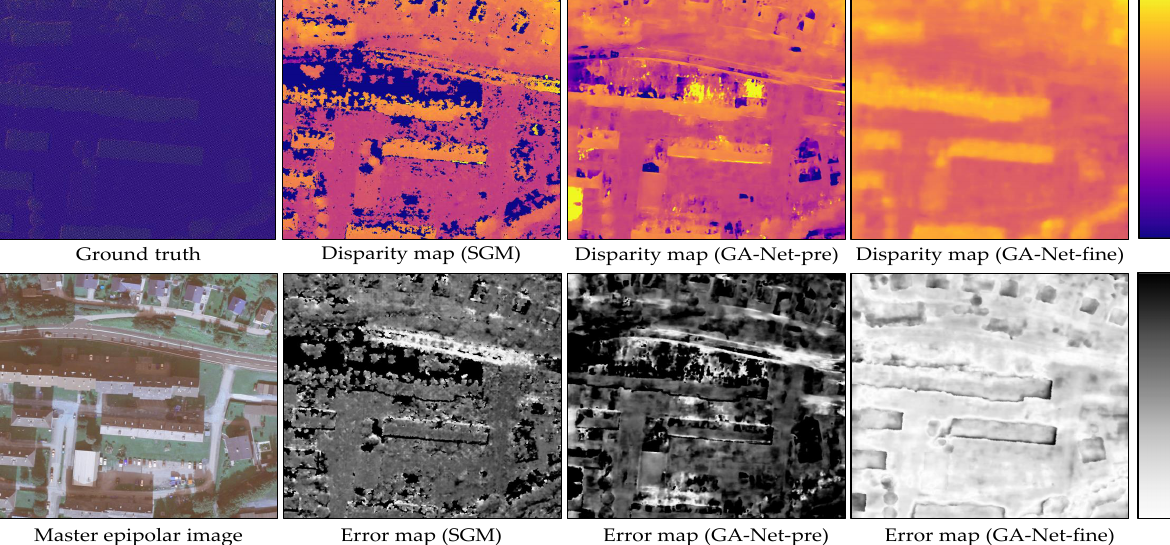
Figure 3. Experiment II: Dense matching results for a validation stereo